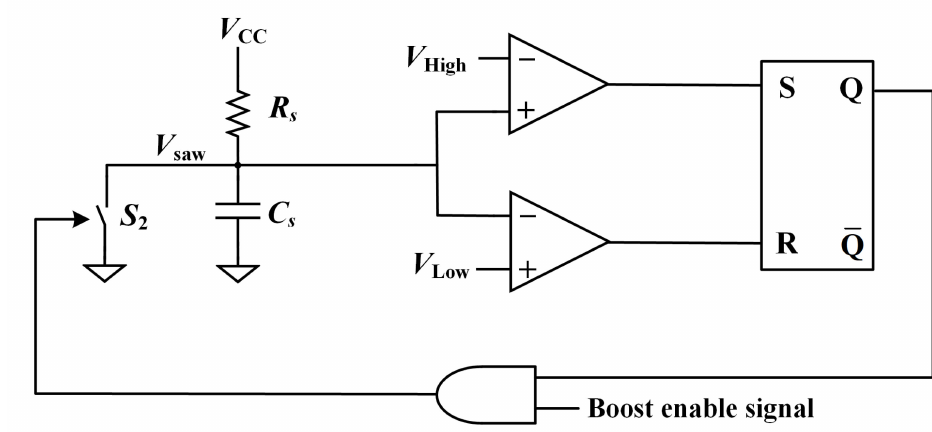
Figure 9. The sawtooth wave generation